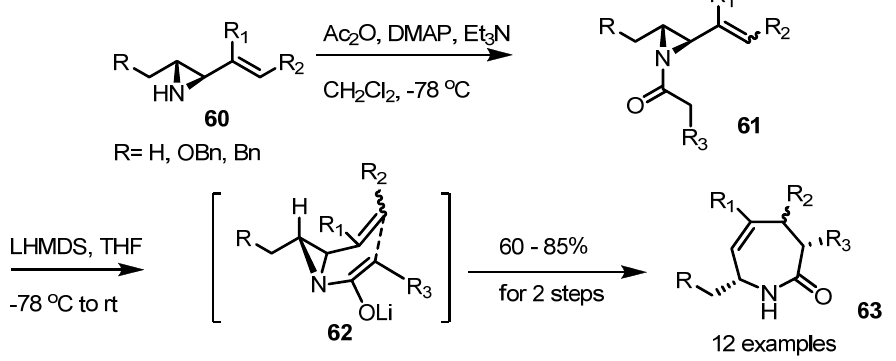
Scheme 19. Aza-Claisen rearrangement of